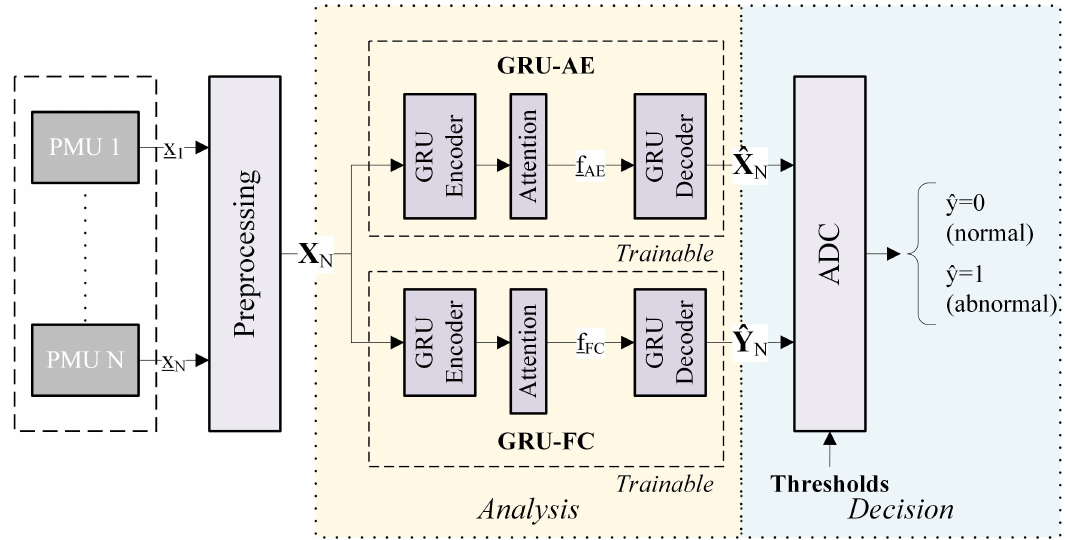
Figure 6. Conceptual overview and workflow of the PADC